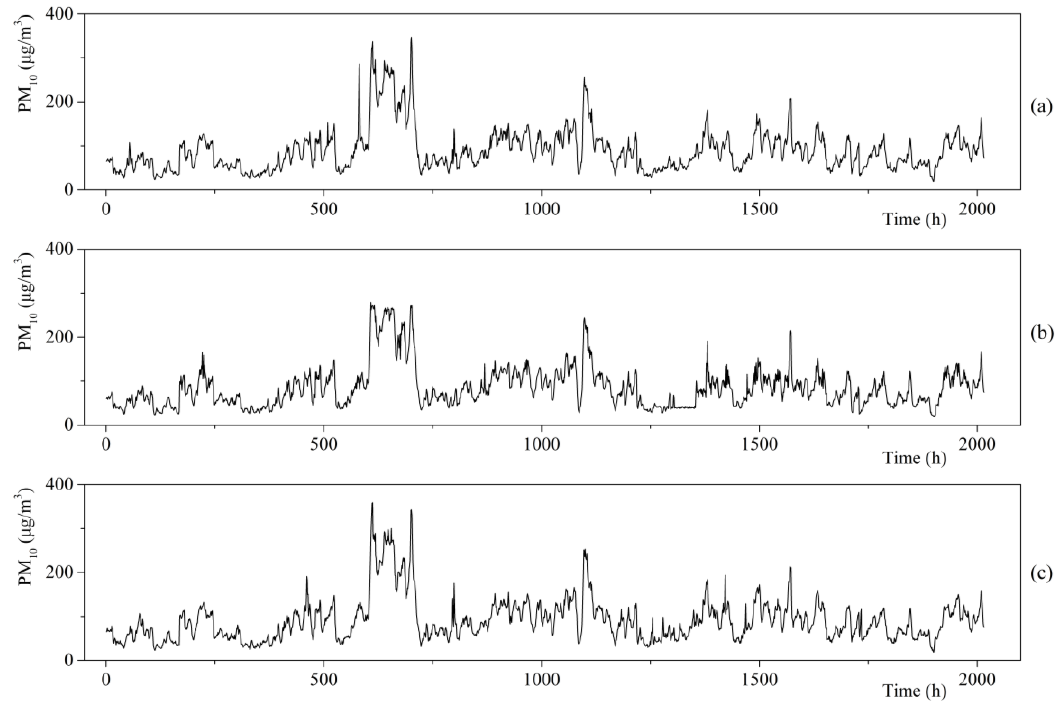
Figure 3. Time-varying characteristics of hourly particulate matter (PM 10 ) concentration: ( a ) the data measured at Site 1; ( b ) the data measured at Site 2; ( c ) the data measured at Site 3. The statistical characteristics of the PM 10 concentration data are shown in Table 1. Table 1. Statistical characteristics of PM 10 concentration data ( µ g / m 3